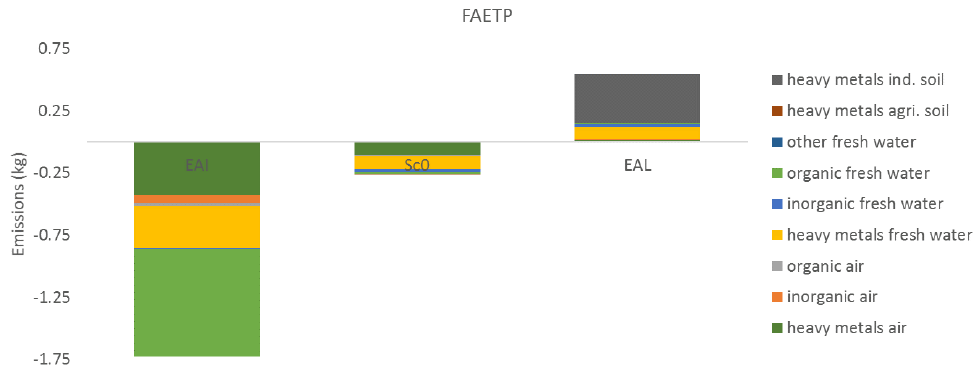
Figure 8. Freshwater ecotoxicity comparison for the reference case (Sc0) among average European scenarios. Results refer to one tonne of treated residues.